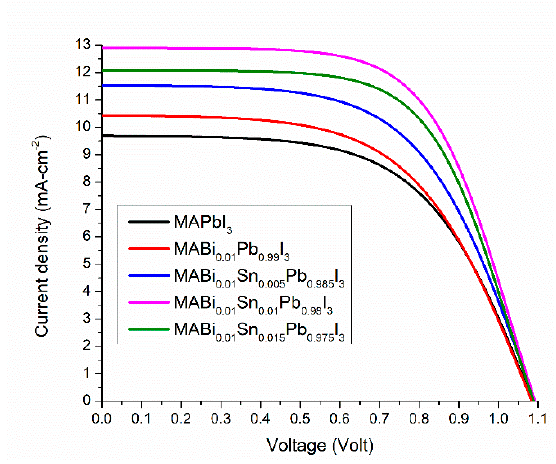
Figure 4. J–V curve of pure and Bi-Sn co-doped MAPbI 3 films. Solar cells parameters, such as short circuit current density (J sc ), fill factor (FF), open circuit voltage (V oc ) and power conversion efficiency ( η %) are measured by the J–V curve and tabulated in Table 3. The below relationship is used to calculate the photovoltaic efficacy of solar cells [60].